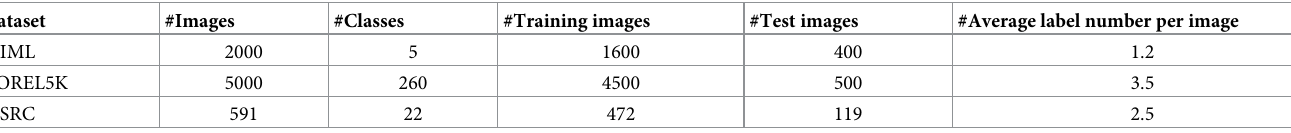
Table 1. Related information of three